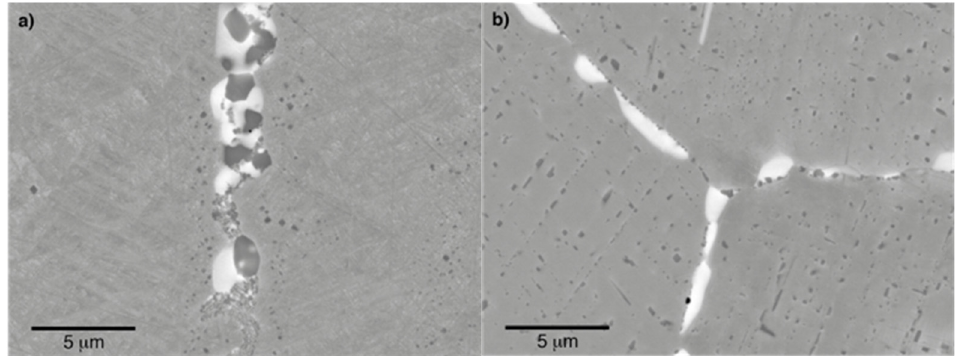
Figure 13. BSE images of the secondary carbide precipitation after oxidation testing at 1000 °C for 100 h of ( a ) as-cast and ( b ) solution heat treated Co-101 specimens.